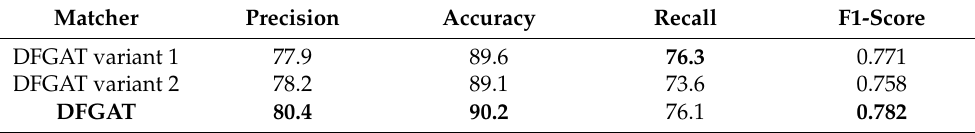
Table 5. Ablation of GAT.